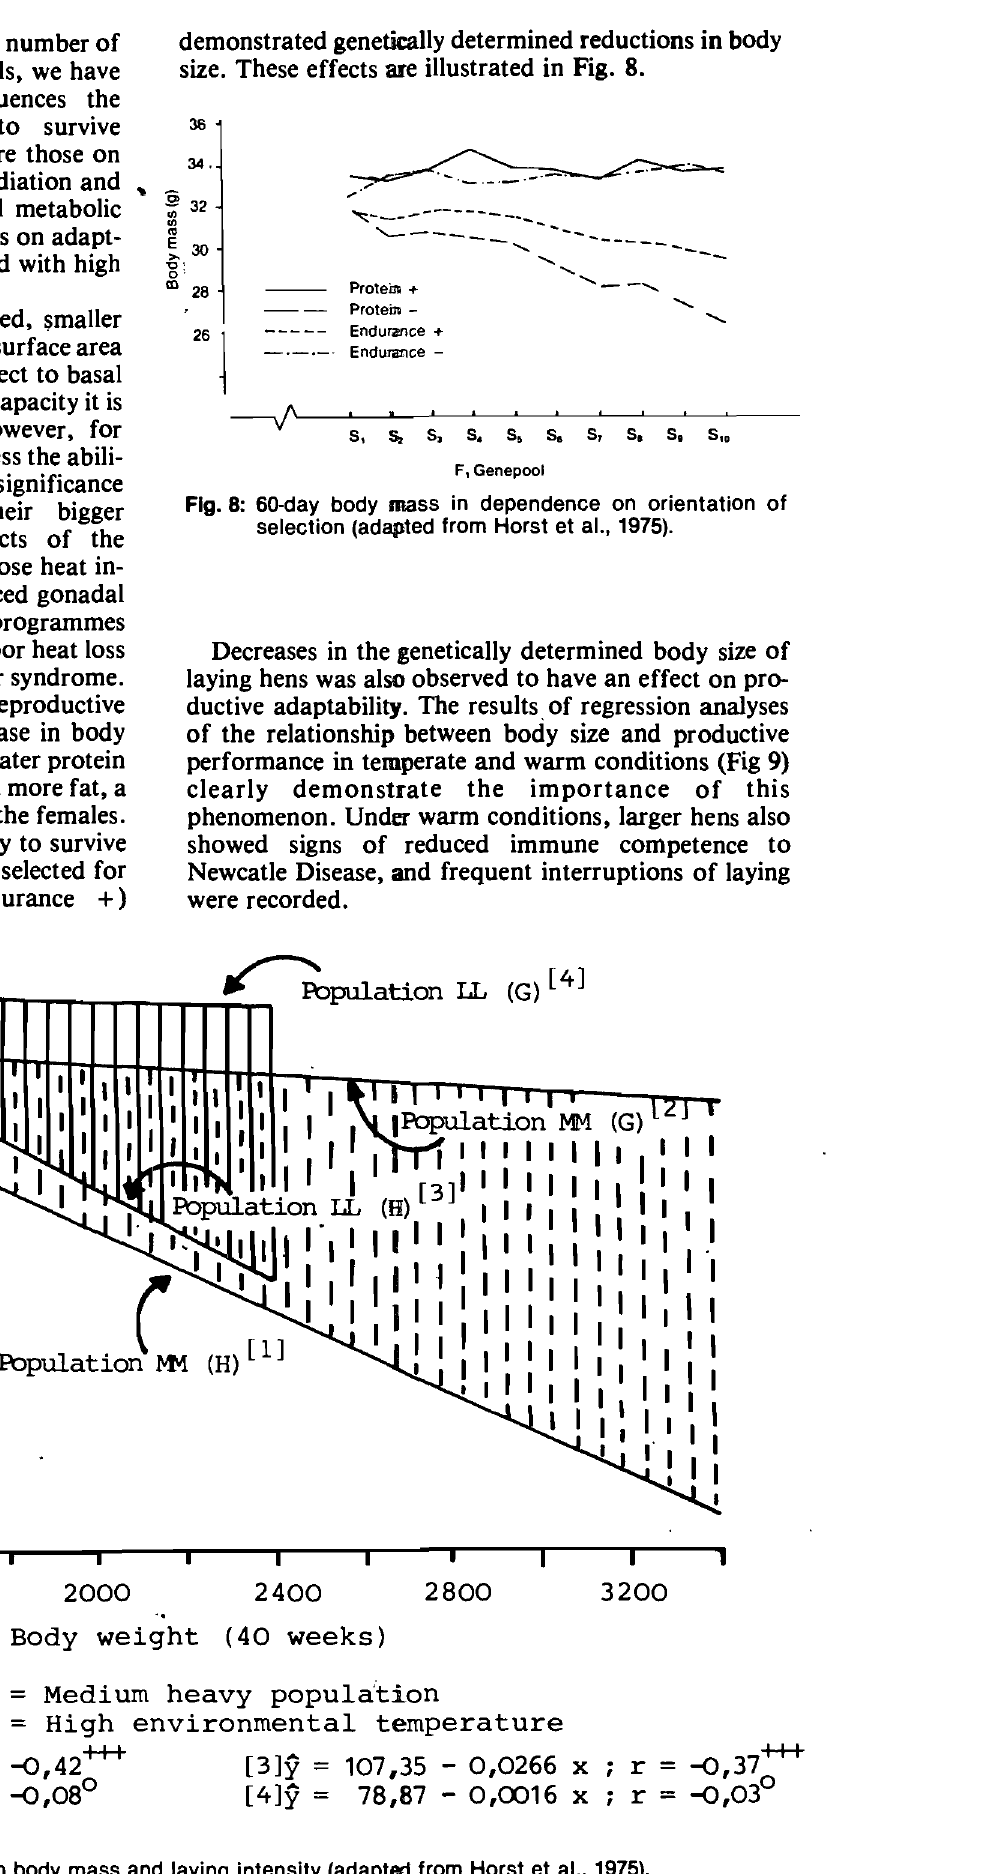
fig. 9: Regression lines for the relation between body mass and laying intensity (adapted from Horst et aI., 1975). TYDSKRIF VAN DIE SUID-AFRIKAANSE VETERINERE VERENIGING-SEPTEMBER